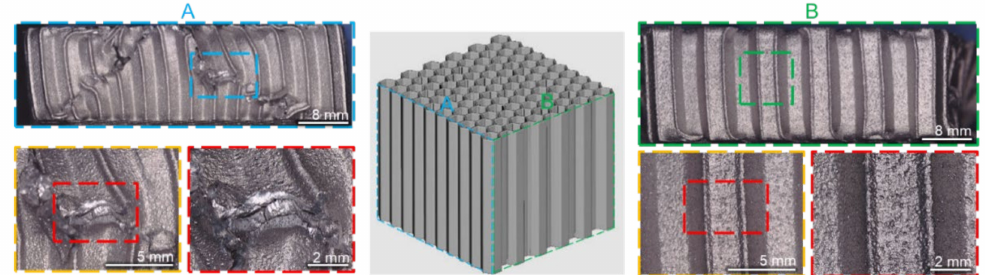
Figure 7. Failure analysis on two surfaces of the 0.8 mm wall thickness honeycomb (relative density of 0.36) showing two inclined failure bands and lateral fractures in the wall evident on surface A ; wall crimping visible on surface B